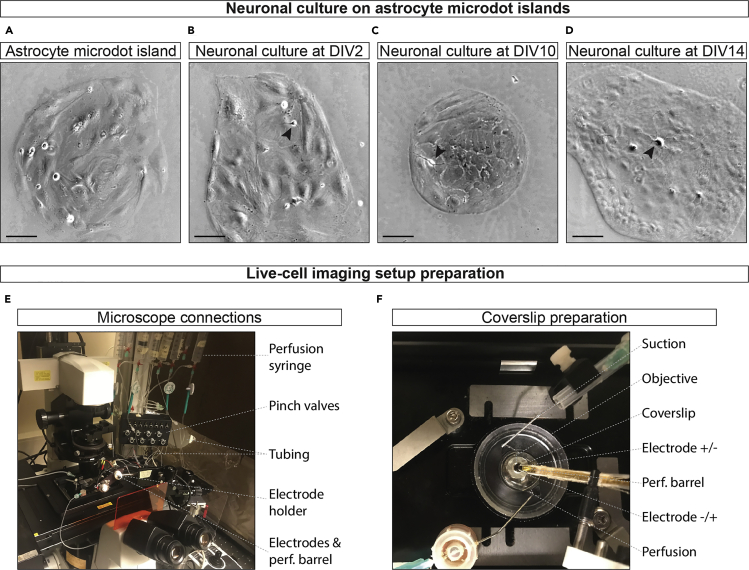
Neuronal culture and microscope setup(A) Example of astrocyte microdot island. Scale bar, 100 μm.(B) Example of hippocampal neuron, indicated by the arrowhead, 2 days after plating (DIV2) on astrocyte microdot. Scale bar, 100 μm.(C) Example of hippocampal neuron (arrowhead) at DIV10 on astrocyte microdot. Scale bar, 100 μm(D) Example of hippocampal neuron (arrowhead) at DIV14 on astrocyte microdot. Scale bar, 100 μm.(E) Live-cell imaging setup with pinch-valve controlled perfusion system, electrodes, and perfusion barrel.(F) Example of a coverslip mounted on the microscope stage with perfusion and suction needles, electrodes, and barrel system to deliver Tyrode’s NH4Cl, or other solutions.